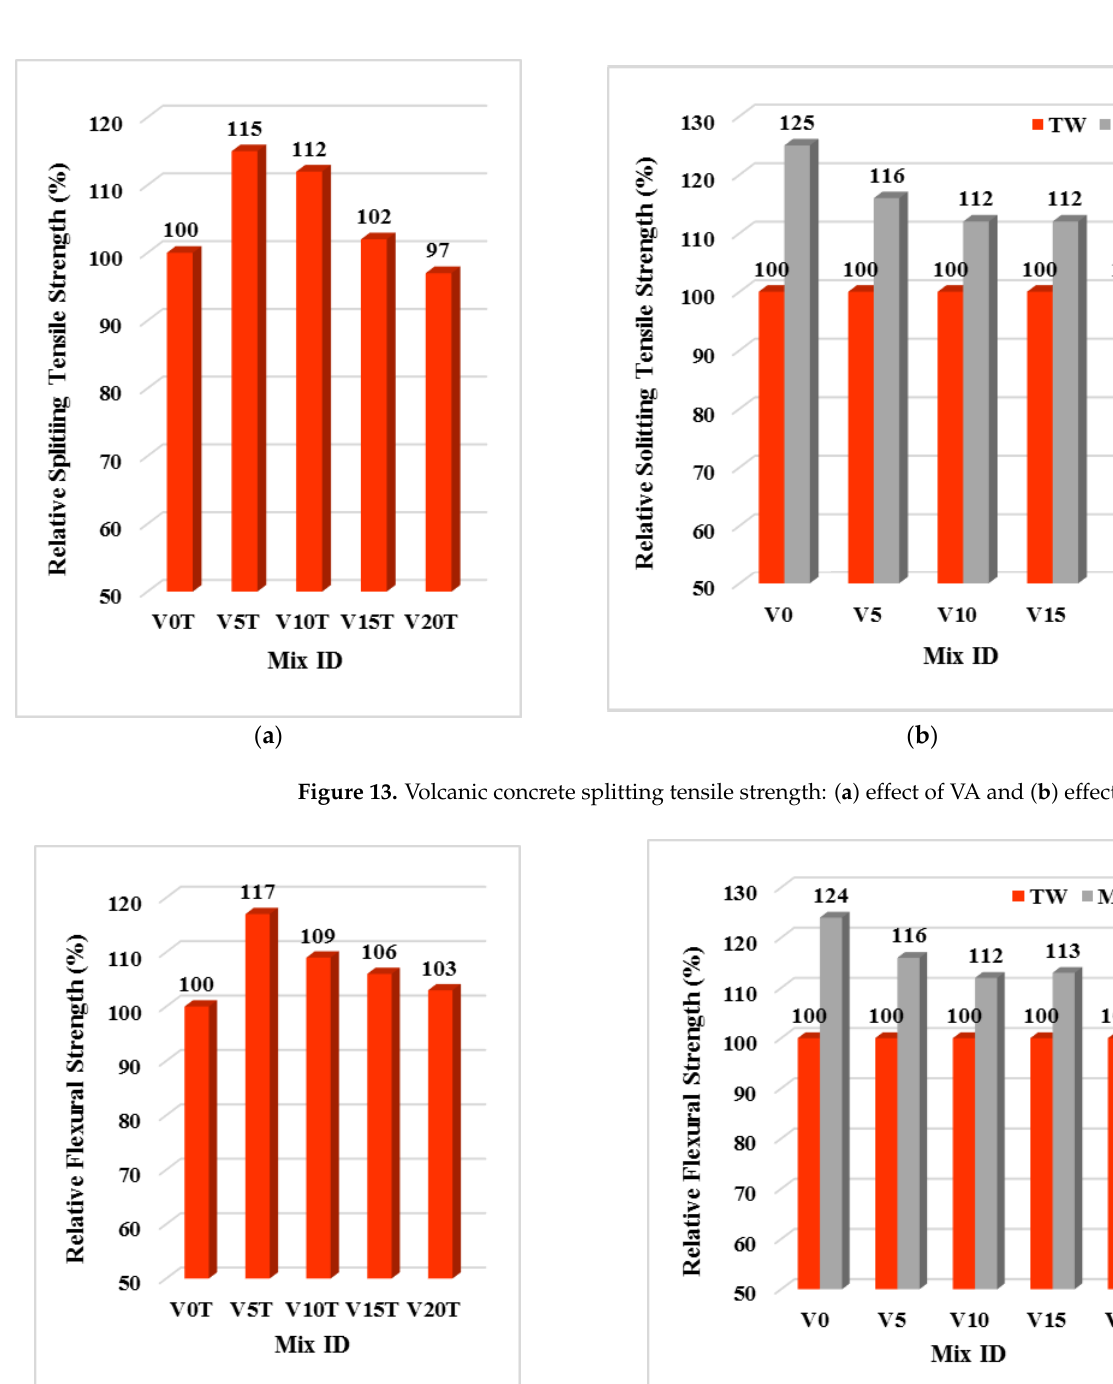
Figure 14. Volcanic concrete flexural strength: ( a ) effect of VA and ( b ) effect of